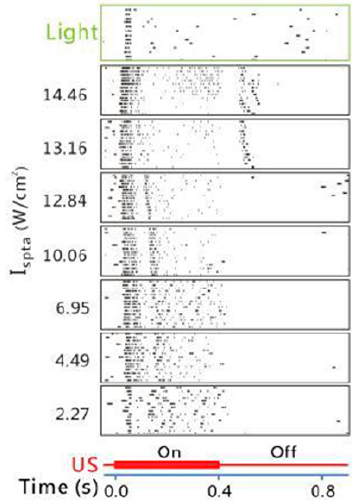
Figure 2. Shift in the response pattern of the retinal ganglion cells with increase of the acoustic intensity. The ON-transient cells (classified by the light response) responded to the onset of the ultrasonic stimuli at lower intensity but responded to both the onset and offset of the ultrasonic stimuli when the ultrasound intensity was increased. (Image from Jiang et al., 2018 [38].)